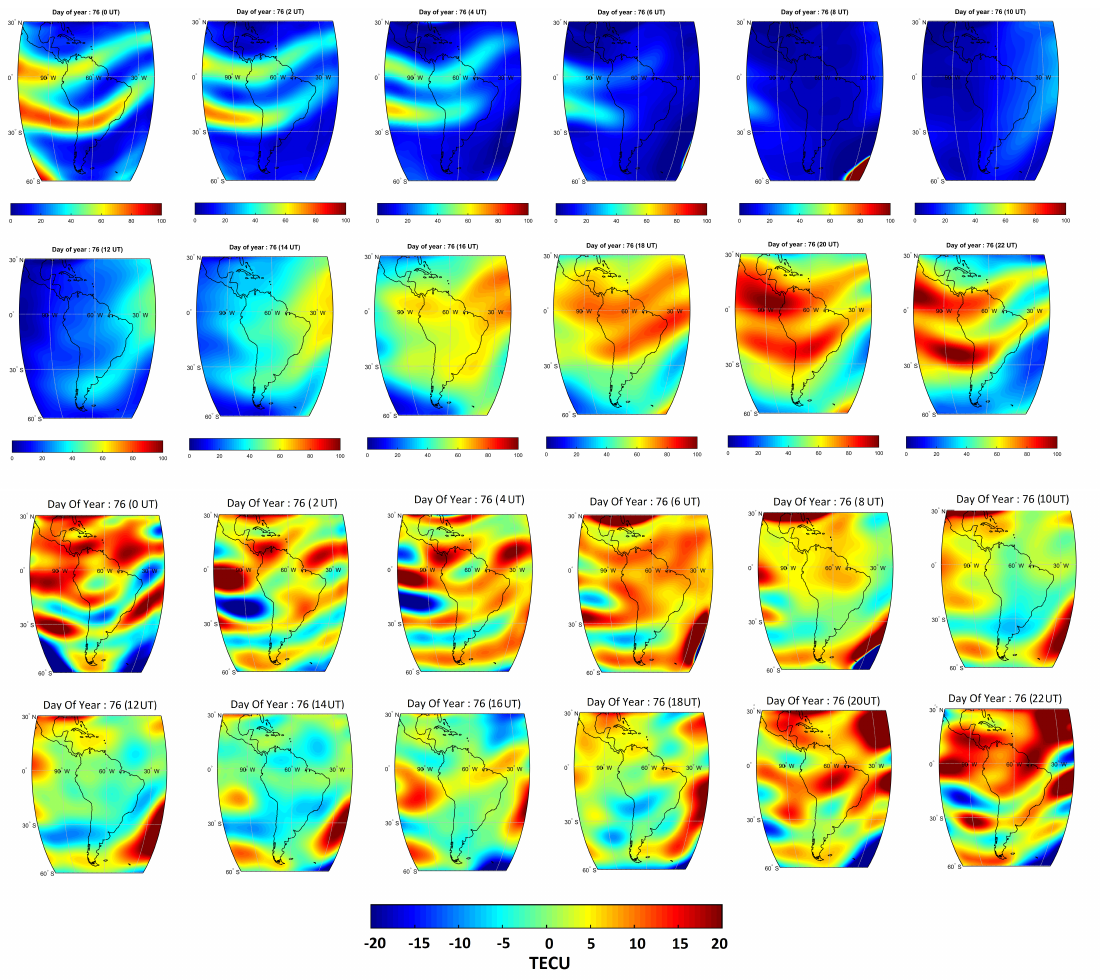
Figure 4. An overview of VTEC changes on 17 March 2013 (DOY 76). The top 12 maps correspond to the regionalized results. The bottom 12 maps are the differences between those of top with the two-hourly GIM/CODE